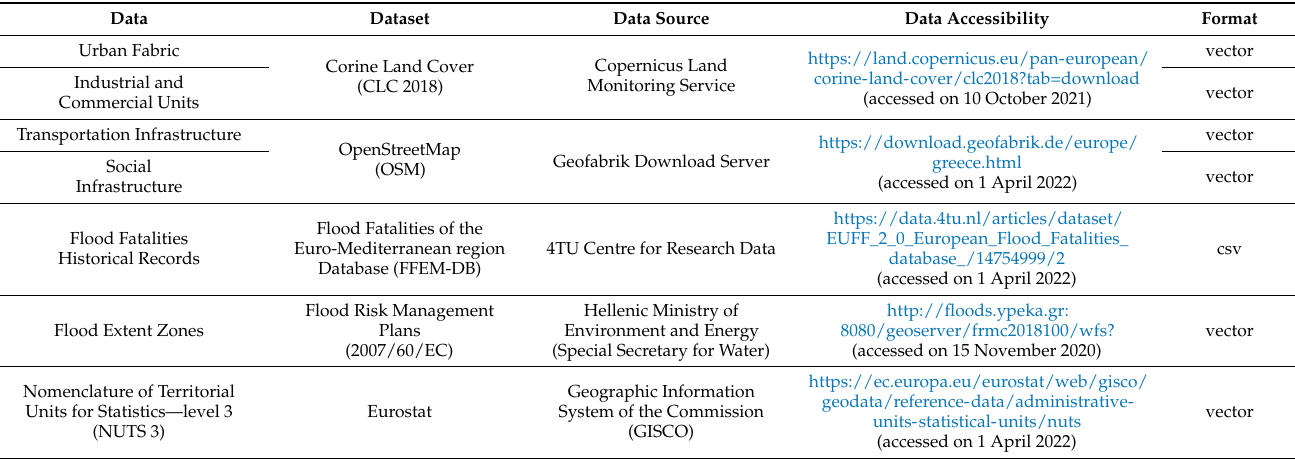
Table 1. Summary of the input datasets and sources used in this